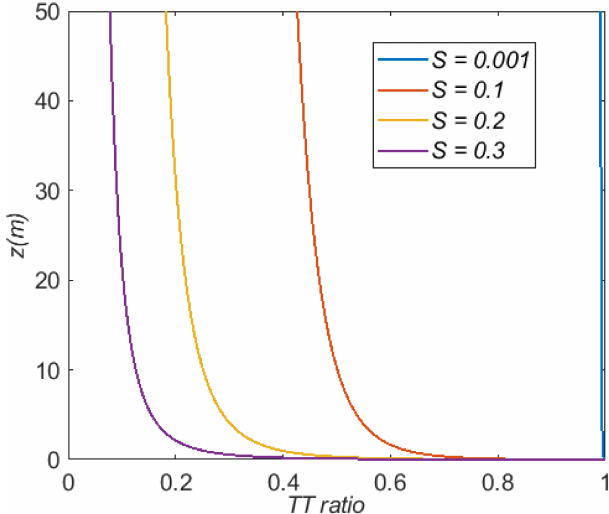
Figure 3. Variation in the turbulent transfer fraction of the total Qc flux and its variation with z and S . Note that these z values are based on z 0c =